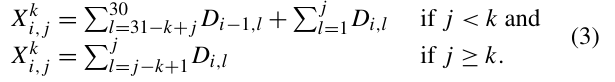
Table 1. Categorization of drought and wet grade according to the SPEI (Wang et al.,